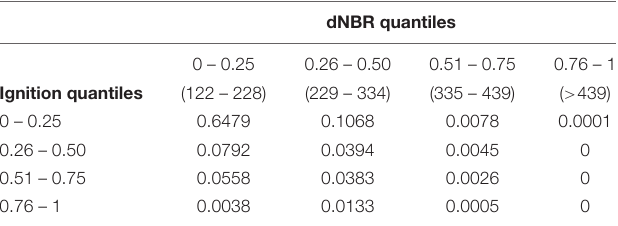
TABLE 4 | Proportion of area in the Mojave Desert in combinations of predicted quantiles of burn severity (difference normalized burn ratio; dNBR) and ignition